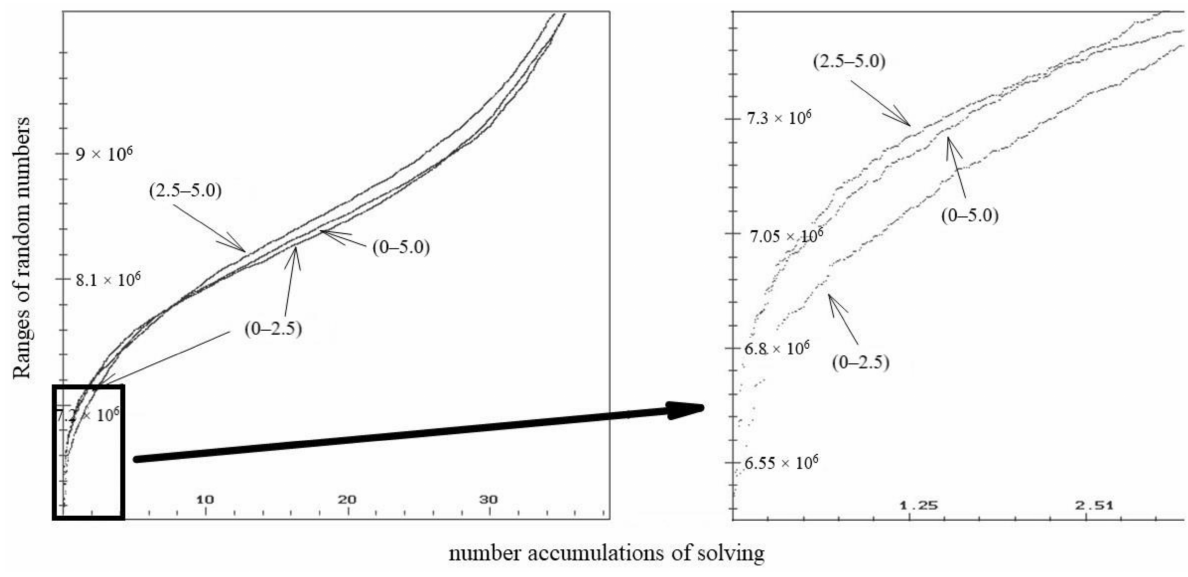
Figure 7. Initial values of the system, and